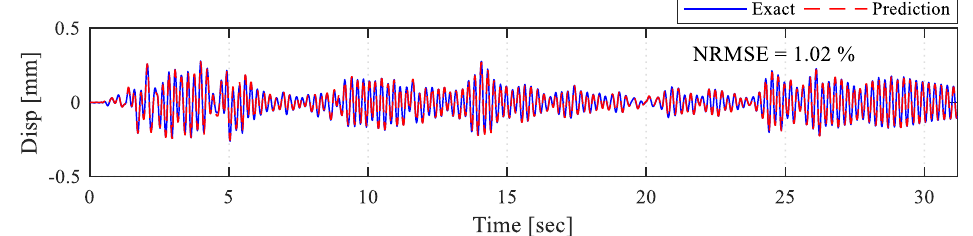
Figure 11. LSTM-predicted brace displacement input from Model 1b virtual HS compared to the exact analytical solution.